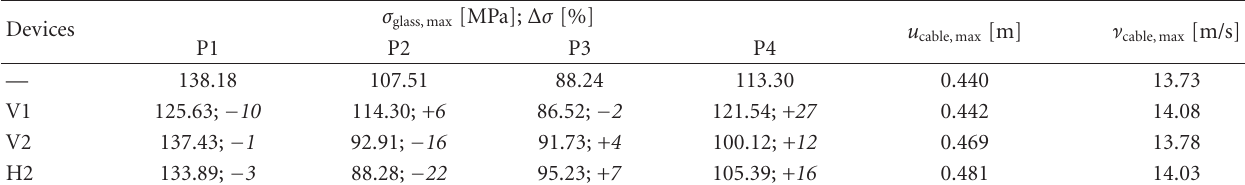
Table 2: Results of incremental analyses (ABAQUS). Glass stresses, deflections, and velocities. M02 FE-model, BL1.